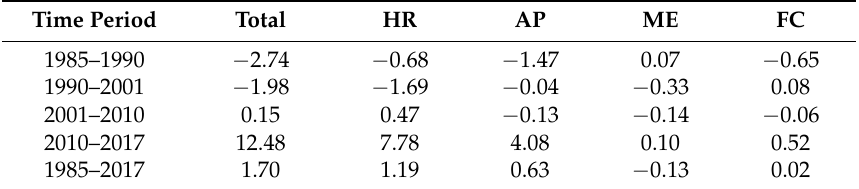
Table 7. Annual rate of the net change of woody vegetation cover for the whole study area (Total) and for the four landscape units: hill range (HR), alluvial plains (AP), metropolitan area (ME) and the floodplain, delta and coastal area (FC). All values in km 2 .